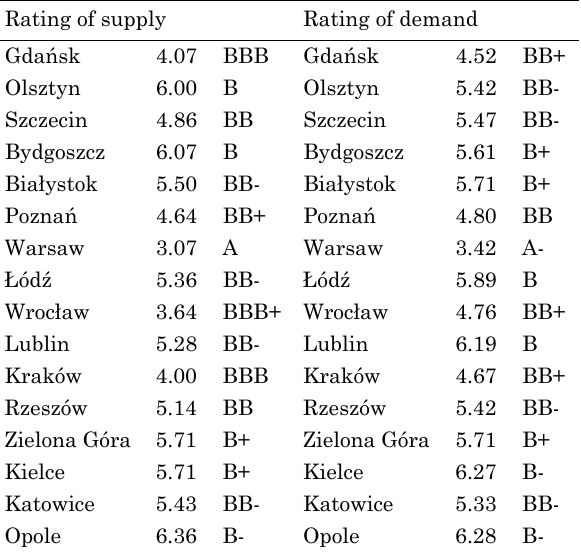
Table 4. “ Average rating scores” for the analyzed real estate